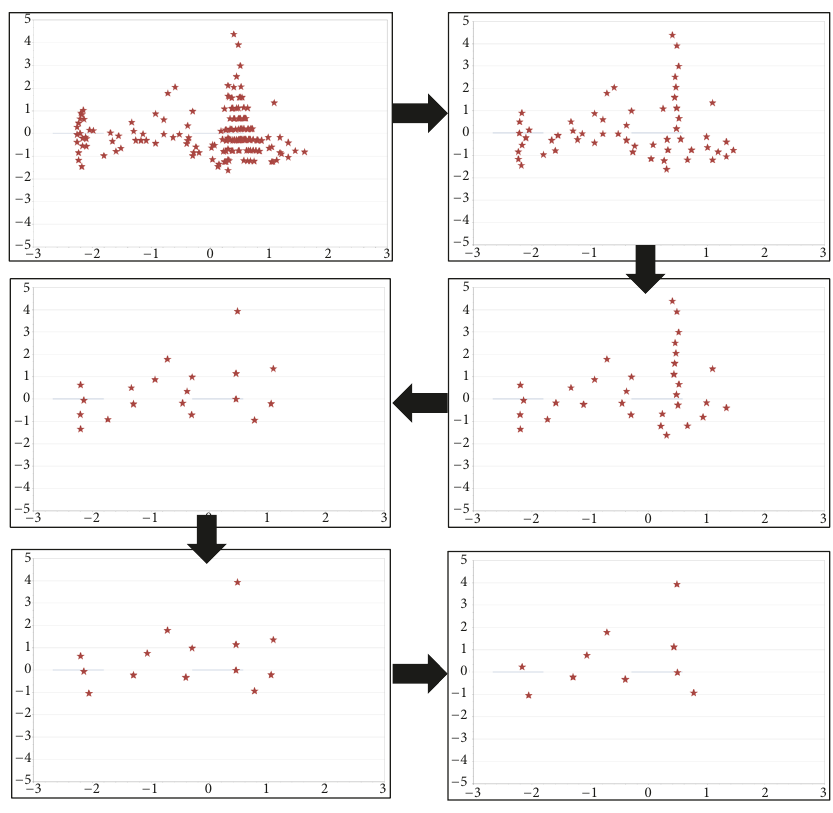
Figure 8: Process of synchronous clustering (SynC) algorithm.